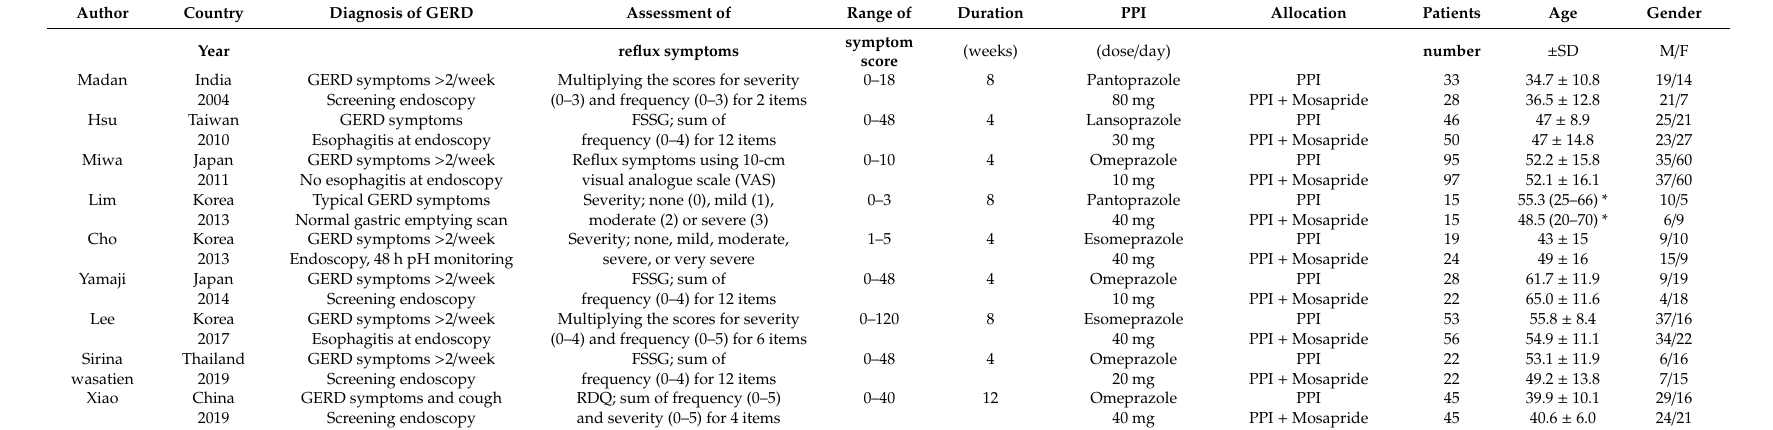
Table 1. Characteristics of studies included in the systematic review.